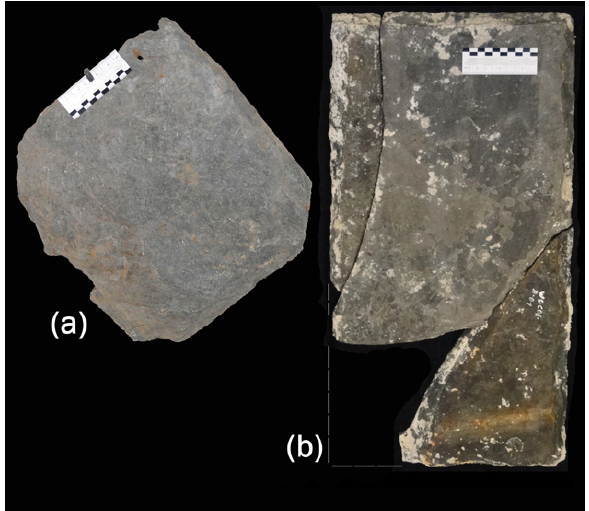
Figure 2. Roman slates: ( a ) Roman Slate, Central Europe; ( b ) Roman Slate, Liguria / Italy (based on [13]).